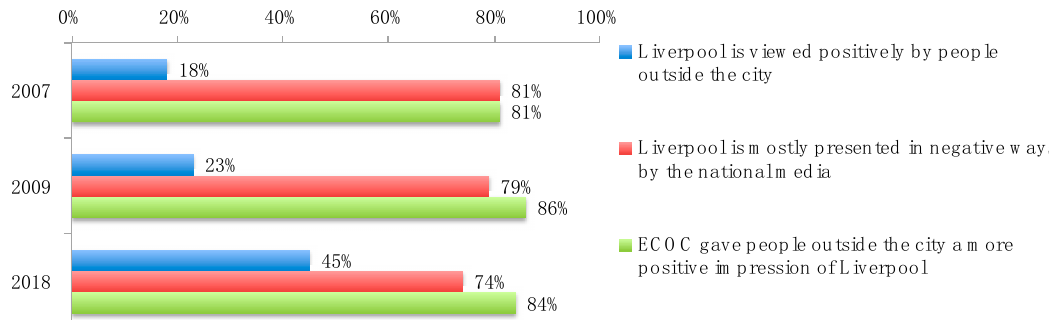
Figure 3. Perceptions of residents about the cultural image effects of Liverpool 2008. Note : These are the 2007, 2009 and 2018 neighbourhood surveys, n = 3,052; number = % of agreement (adapted from http://iccliverpool.ac.uk/impacts18).